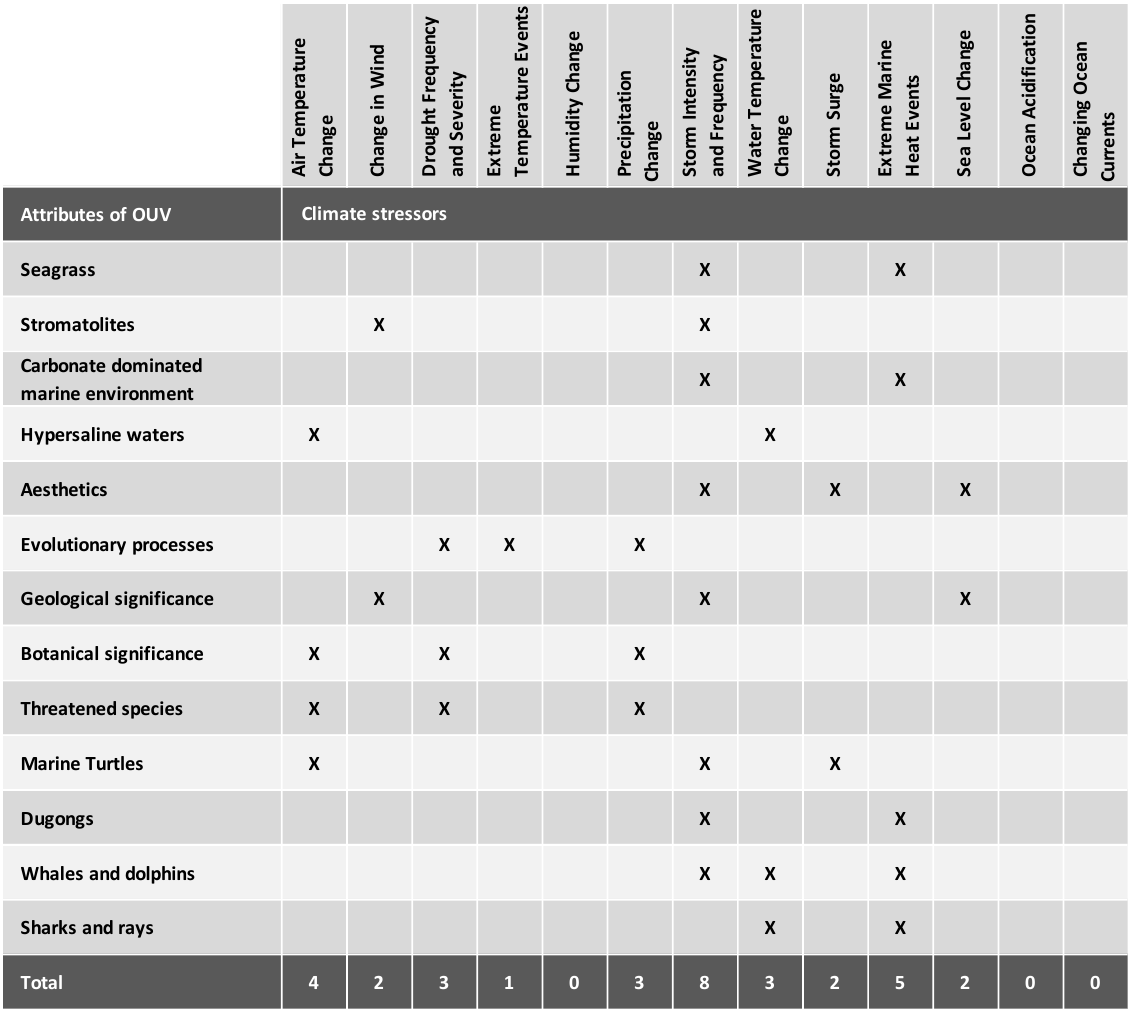
Table 5.1 Climate stressors identified as likely to have the greatest impact for each of 13 attributes of OUV. Marked cells indicate that the climate stressor was in the top three responses for each key value. Stressor impacts were assessed for ca.